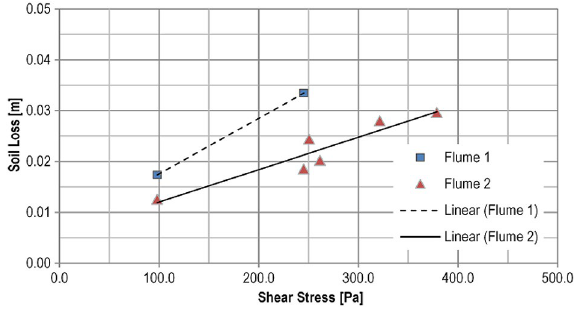
Fig. 9. Erosion rates flumes 1 & 2 (unvegetated); soil loss and shear stress, steep trend line = high erosion rate, September